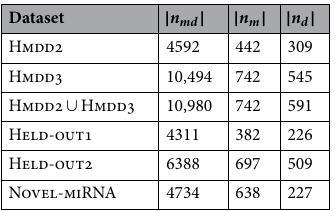
Table 1. The association data statistics where | n md | , | n m | , | n d | refer to the number of associations, miRNAs and diseases